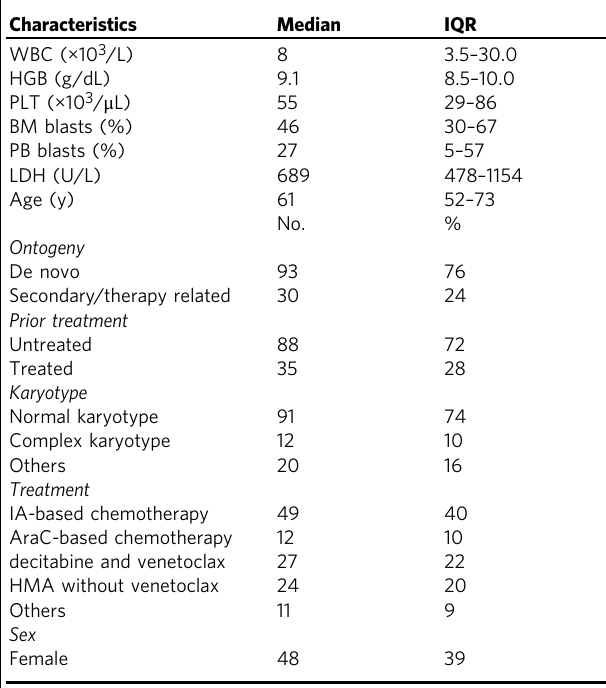
Table 1 Clinical and demographic characteristics of the study cohort ( N =